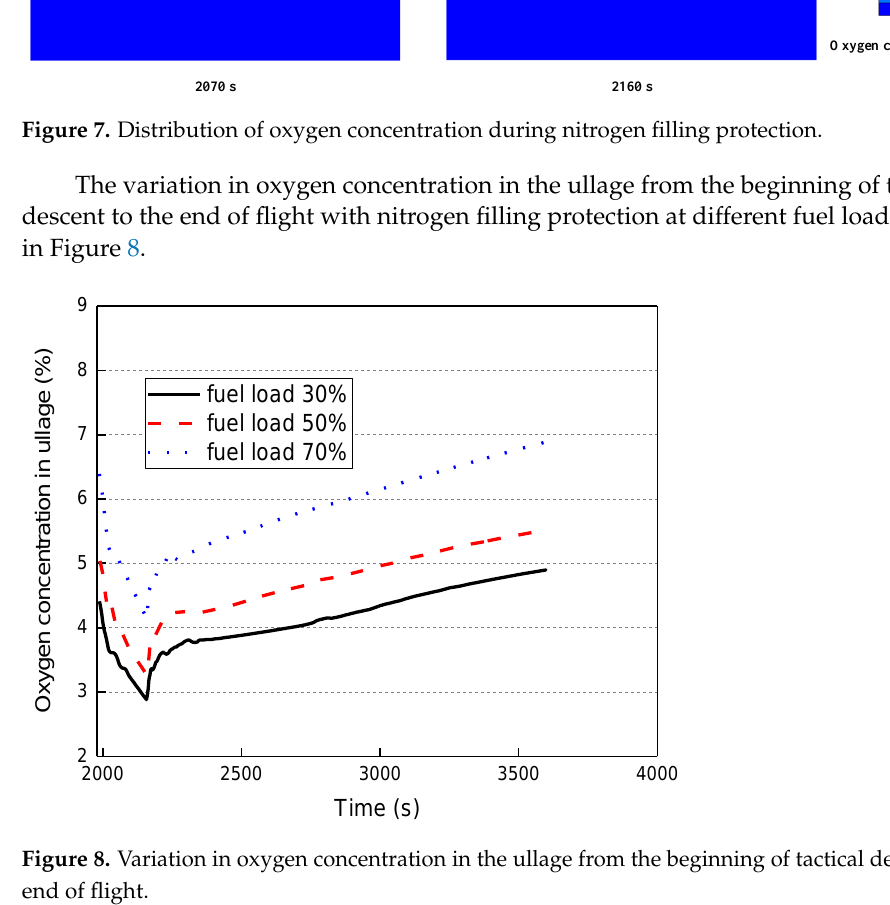
Figure 8. Variation in oxygen concentration in the ullage from the beginning of tactical descent to the end of flight.